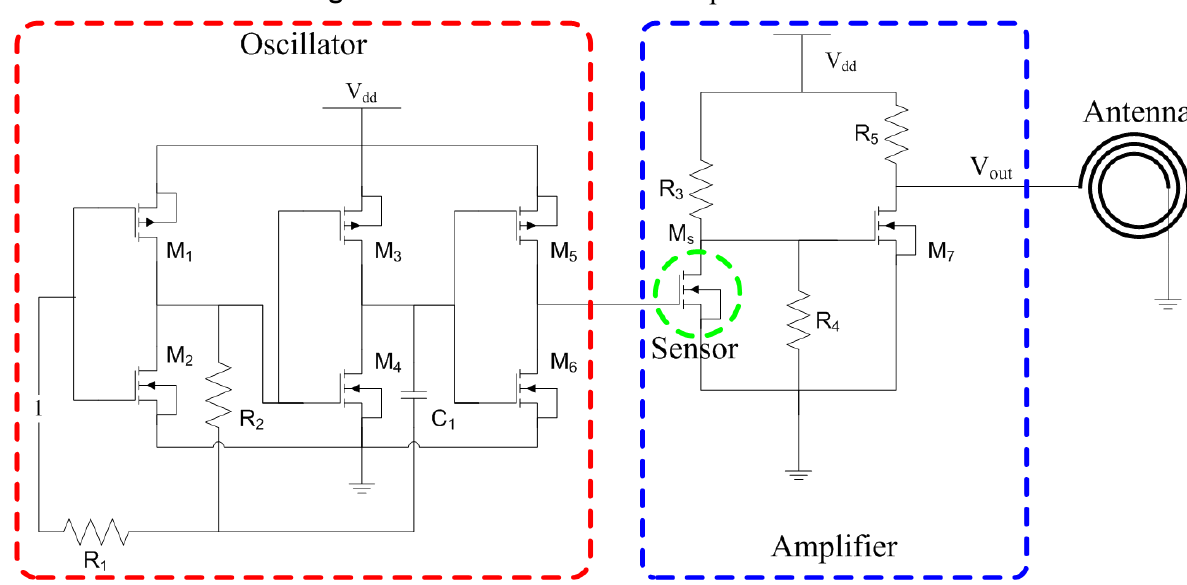
Figure 3. Circuits of the wireless pressure